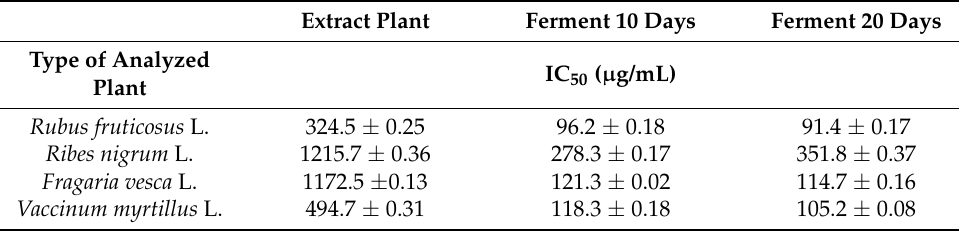
Table 3. Values of IC 50 of DPPH radical scavenging for R. fruticosus L., R. nigrum L., F. vesca L., V. myrtillus L. extract and kombucha ferments after 20 min of exposure. Values are means ± standard deviation (SD) of